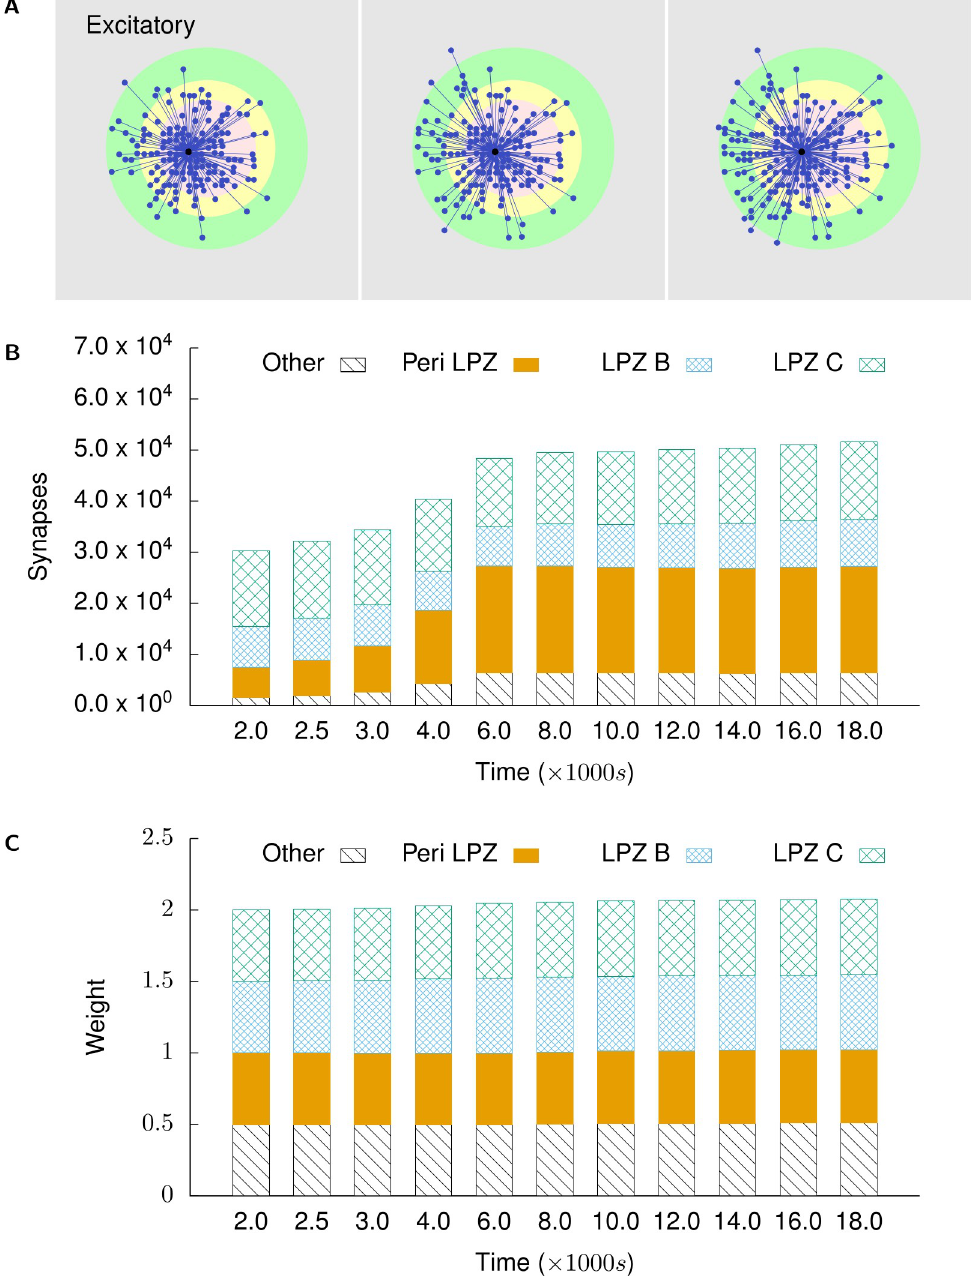
Fig 6. Excitatory projections to excitatory neurons in the centre of the LPZ. (A) shows incoming excitatory projections to a randomly chosen neuron in the centre of the LPZ at different stages of our simulations. From left to right: t = 2000 s, t = 4000 s, and t = 18,000 s. (B) shows the total numbers of incoming excitatory projections to neurons in the centre of the LPZ from different regions at different points in time. (C) shows the mean weight of projections received by neurons in the centre of the LPZ from different regions at different points in time. Following our proposed growth rules for post-synaptic elements and consistent with experimental reports, the deprived neurons in the LPZ C gain lateral excitatory inputs from neurons outside the